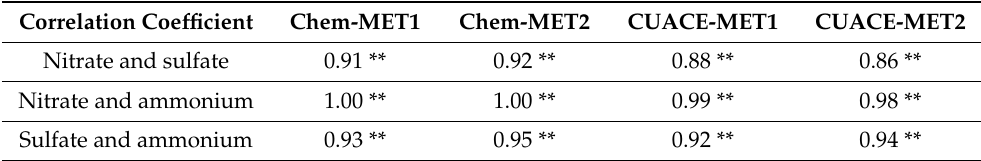
Table 7. Correlations among nitrate, sulfate and ammonium concentrations in the four groups of test results. Correlation Coefficient